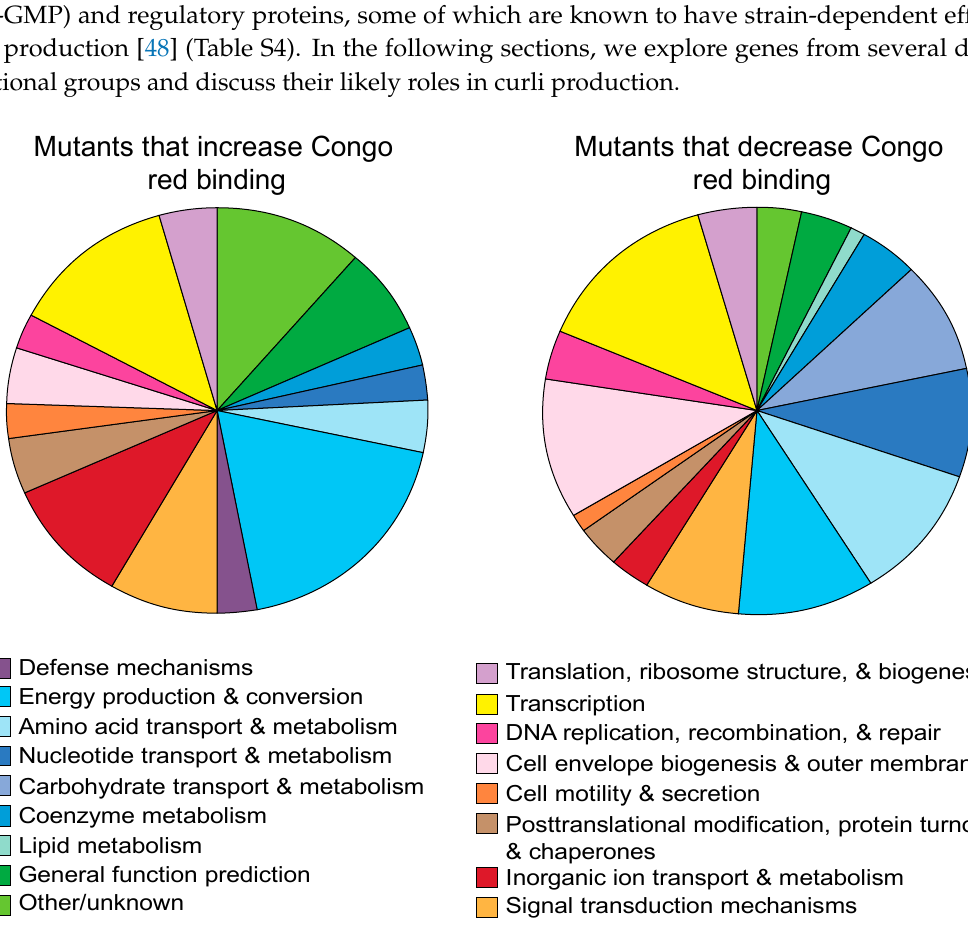
Figure 2. Genes affecting curli production perform diverse roles. Genes identified for altered curli production sorted by clusters of orthologous groups (COGs) showed involvement of regulation, environmental sensing, metabolism, cell envelope biogenesis, transport, and protein turnover in curli production.